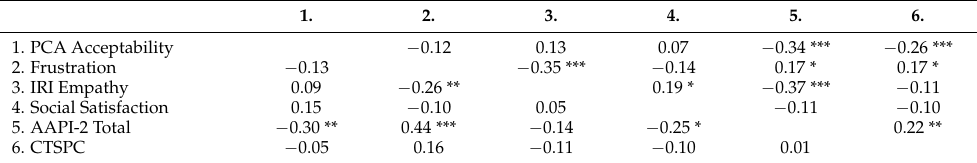
Table 2. Correlations among outcome measures by group.